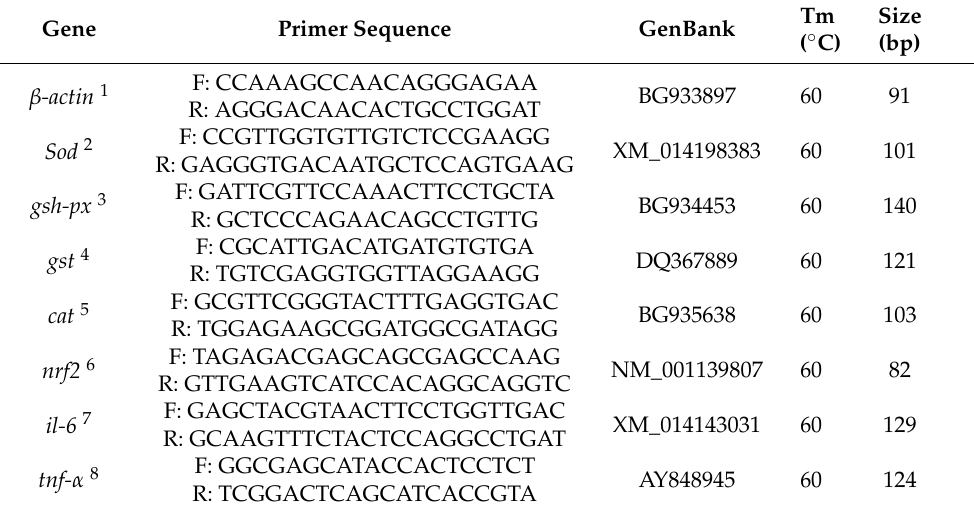
Table 2. Real-time quantitative PCR primers for genes of coho salmon.